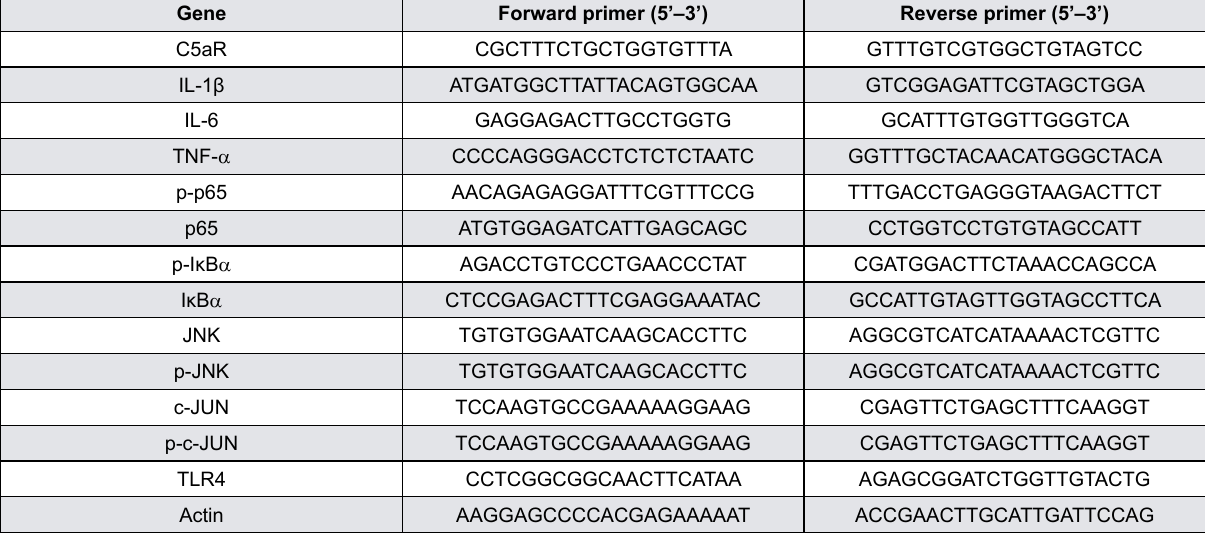
Figure 1- Primer sequences used for RT-PCR and